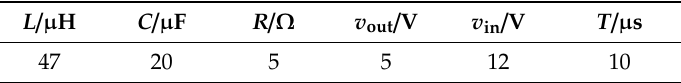
Table 2. Specifications of the buck converter.